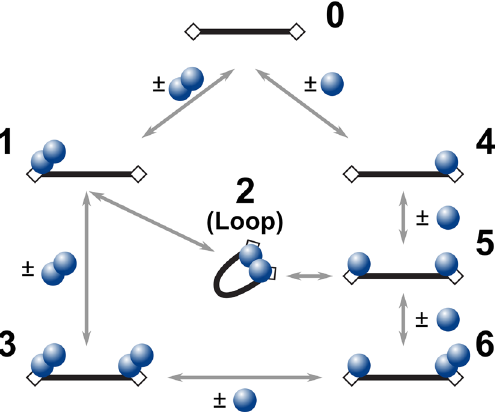
Figure 6. Kinetic schemes depicting possible reaction pathways between a two-target site DNA fragment and WT AfAgo. Black bars represent DNA, rectangular boxes—AfAgo-binding targets (phosphorylated DNA ends), blue circles—AfAgo monomers. Numbering of various protein–DNA assemblies matches numbering of complexes observed by AFM (Fig. 3). Note that species 1 and 6 may be formed via alternative pathways not depicted in the scheme (species 1 may be formed when two monomers associate consecutively with the same DNA end; species 6 may be formed when a monomer and a dimer associated with different DNA